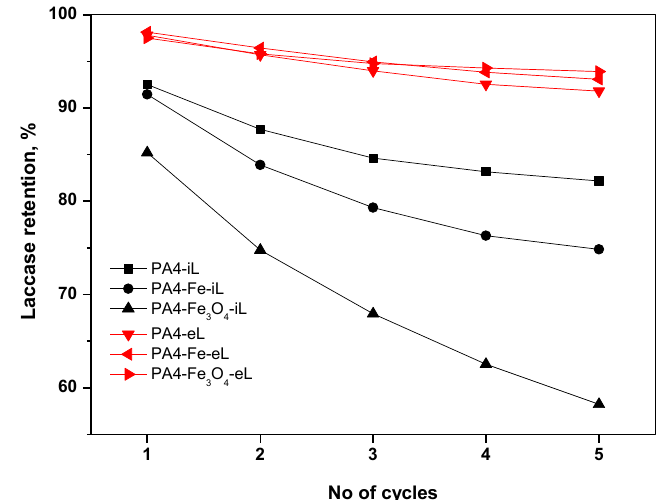
Figure 10. Laccase retention as a function of the immobilization strategy and cycles of application.